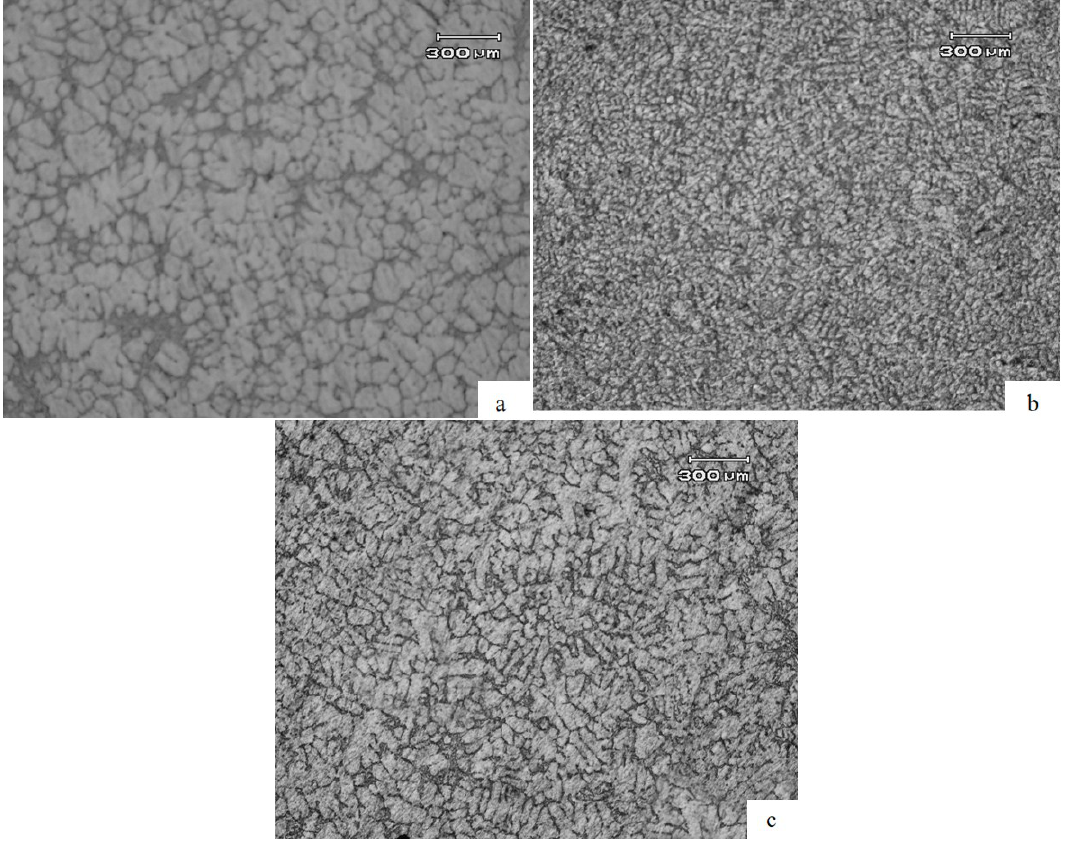
Figure 9. ( a ) Microstructure of the A356 matrix alloy with no stirring. ( b ) Microstructure of A356 nanoreinforced with Al 2 O 3 . ( c ) Microstructure of A356 nanoreinforced with TiO 2